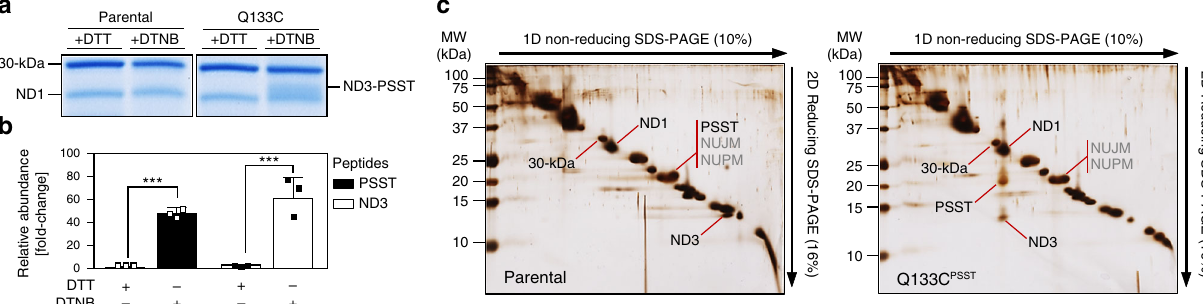
Fig. 1 A disul fi de cross-link is formed between subunits ND3 and PSST in mutant Q133C PSST . Puri fi ed complex I from parental and mutant strains were incubated with either 5 mM dithiothreitol (DTT) or 0.1 mM 5,5 ′ -dithiobis-2-nitrobenzoic acid (DTNB) for 5 min and then separated by non-reducing Tricine SDS-PAGE. a An additional band was observed in the sample from mutant Q133C PSST treated with DTNB. b Mass spectrometric analysis of the corresponding gel slice con fi rmed the presence of cross-linked subunits PSST and ND3 and allowed label free quanti fi cation of their relative abundance as compared to the corresponding gel slice of the DTT treated sample (mean ± s.d.; n = 3 technical replicates; *** p < 0.001, ANOVA with Bonferroni correction). c Subunits PSST and ND3 were also identi fi ed by dSDS-PAGE, in which the cross-link was preserved in the fi rst dimension (1D) and then reduced in the second dimension (2D) to separate both proteins at a shifted position in the mutant. Note that the spot containing subunit PSST does not disappear after cross-linking, because it also contains accessory subunits NUJM and NUPM 37